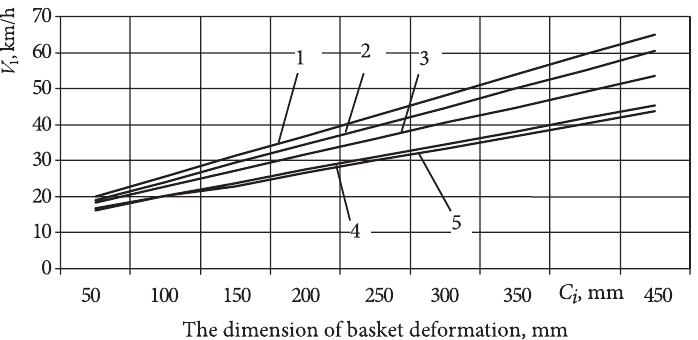
Fig. 11. Dependence of car speed before hit on car deformation aft er hit C and car stiff ness in case of front collision with a wall, i when coeffi cients of stiff ness are the following: 1 – A = 95.2 kN/m, B = 760 kN/m 2 ; 2 – A = 65.5 kN/m, B = 500 kN/m 2 ; 3 – A = 63.8 kN/m, B = 400 kN/m 2 ; 4 – A = 63.9 kN/m, B = 358 kN/m 2 ; 5 – A = 74.5 kN/m, B =480 kN/m